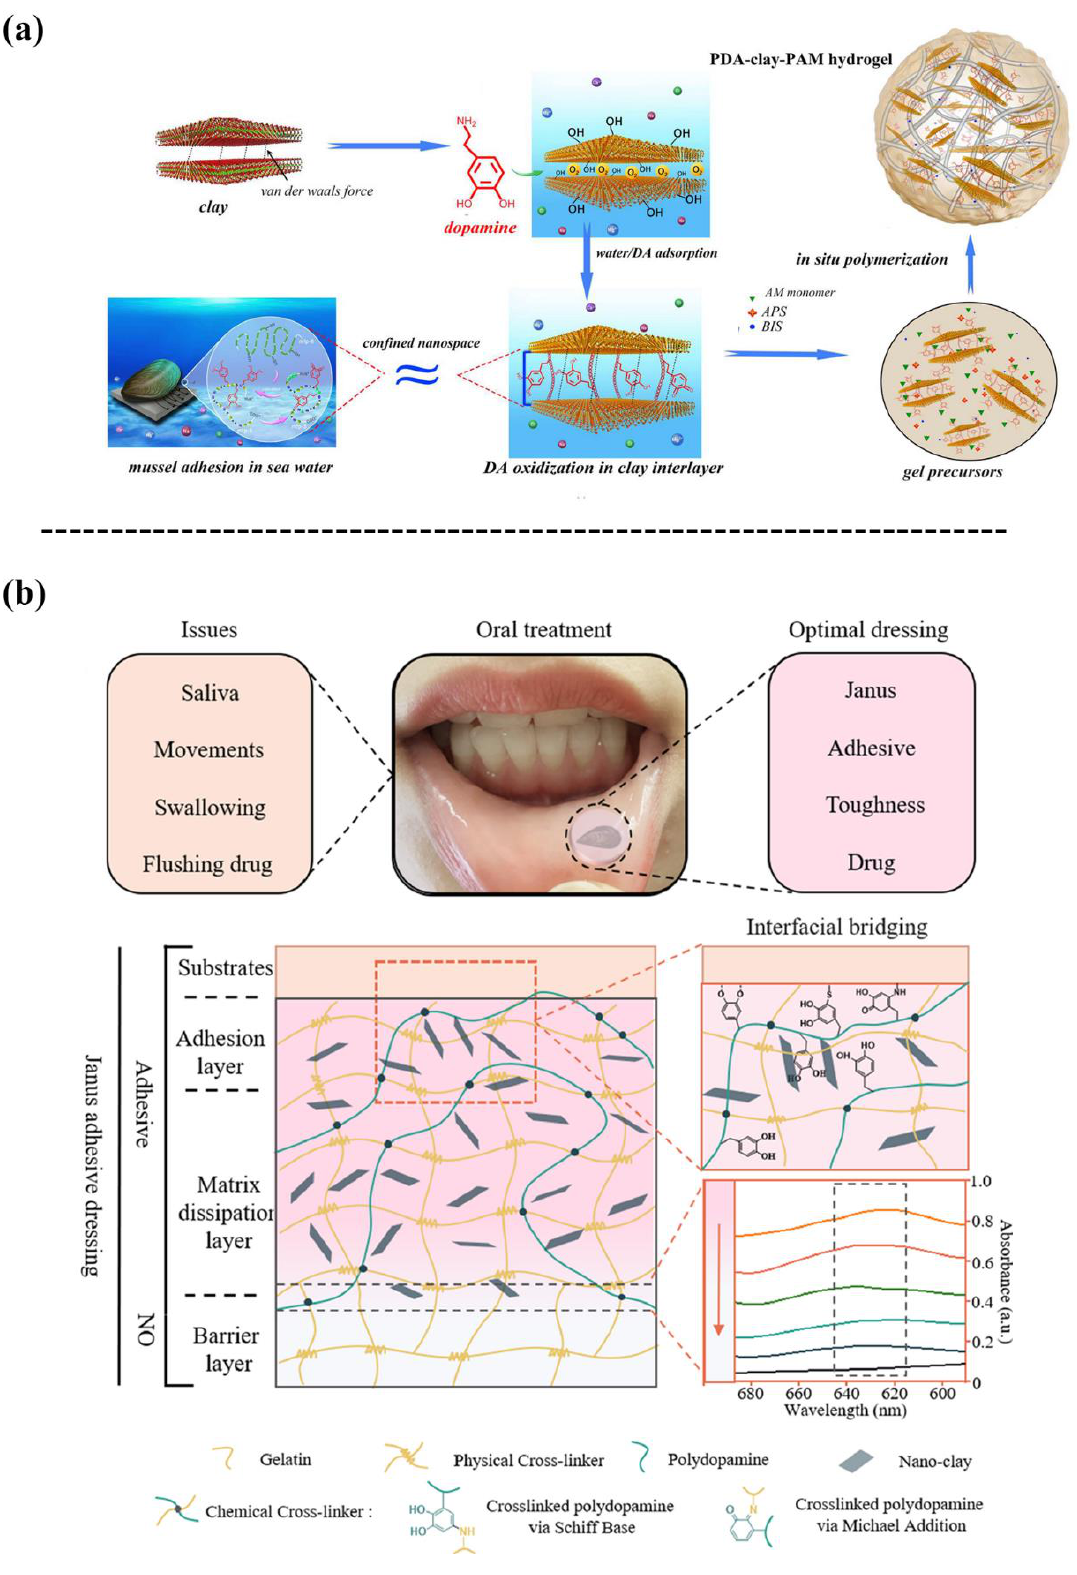
Figure 17. ( a ) Design strategy for the preparation of a mussel-inspired adhesive polydopamine-clay-polyacrylamide (PDA-clay-PAM) hydrogel by the confined oxidation of dopamine [86]. ( b ) Fabrication of a mussel-inspired Janus mucosal dressing with a tough and adhesive hydrogel composed of gelatin, polydopamine, and nano-clay to achieve drug release [87].